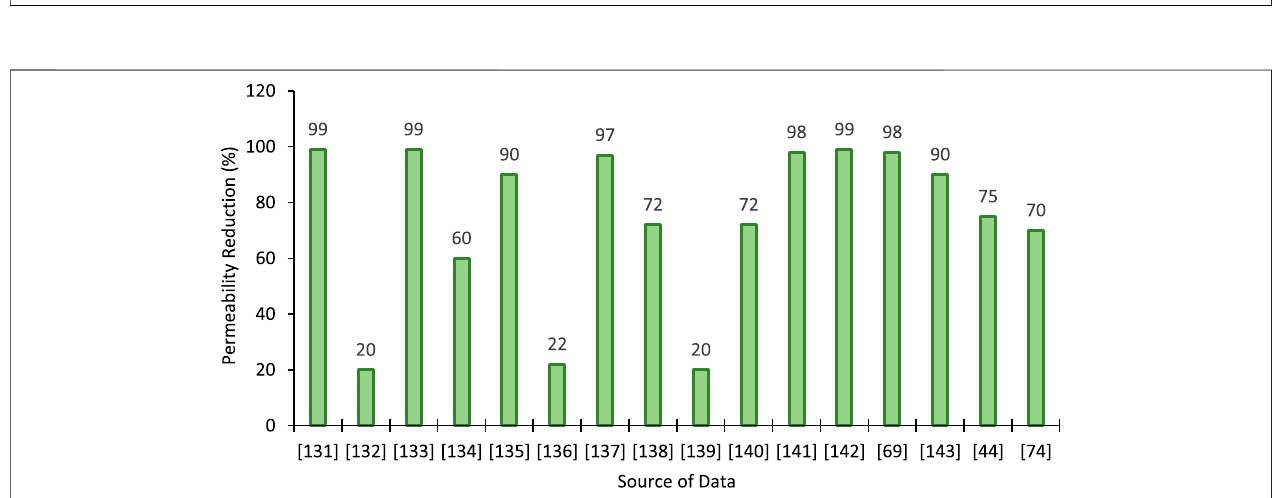
FIGURE4| PermeabilityreductionafterEICPtreatmentreportedintheliterature[Datasourcedfrom(Cunninghametal.,1991;FerrisandStehmeier,1992;Ragusa et al., 1994; Nemati and Voordouw, 2003; Whif fi n et al., 2007; Ivanov and Chu, 2008; Van Loosdrecht and Van Paassen, 2009; Yasuhara et al., 2012; Handley-Sidhu et al., 2013; Qabany and Soga, 2014; Ivanov et al., 2010; Soon et al., 2014; Proto et al., 2016; Zamani and Montoya, 2016; Gui et al., 2018; Moghal et al., 2020b)].